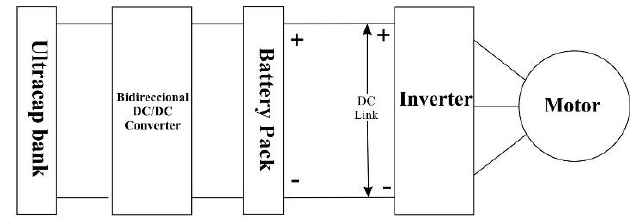
Figure 2. Ultracapacitor/battery configuration [7]. DC/DC: direct current to direct current.